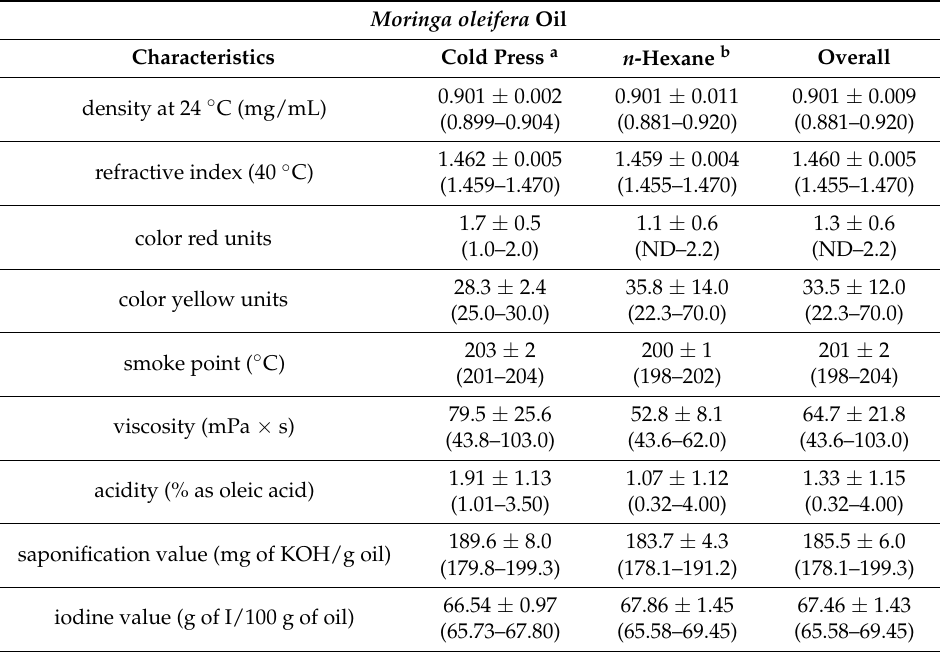
Table 2. Physical and chemical characteristics of the oil.